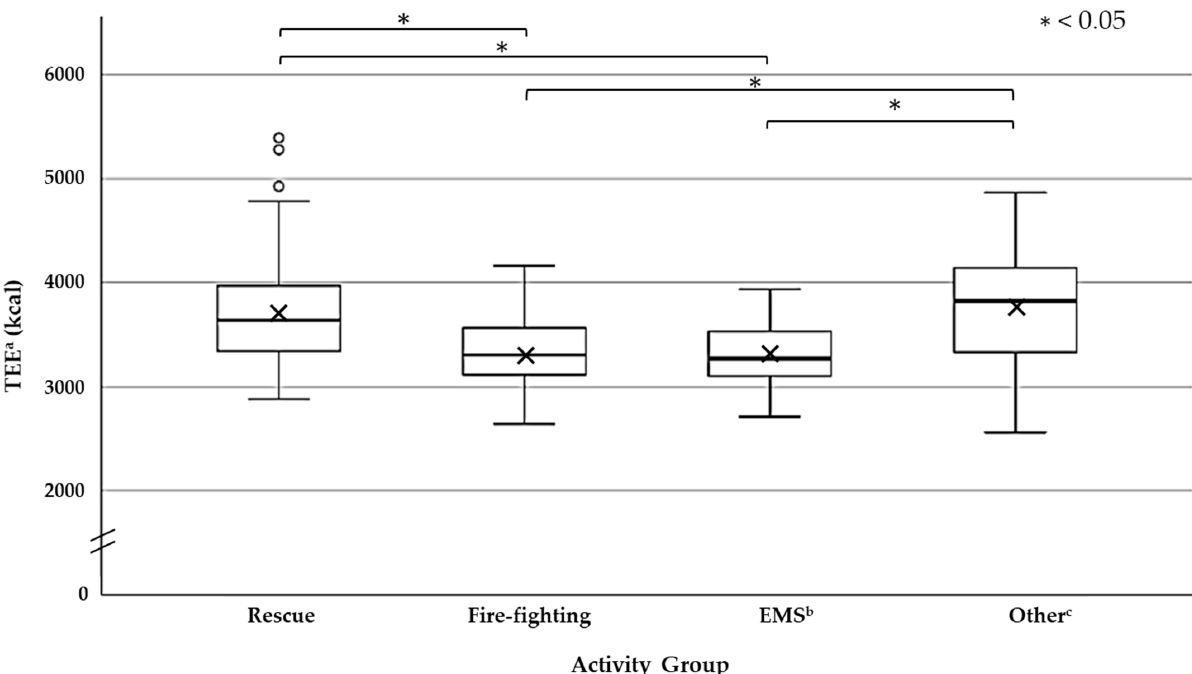
Figure 2. Total energy expenditure (TEE) of each disaster response Activity Group (24 h from arrival at the disaster site to the end of the disaster response activity during the two days of activity training). The TEE of the Rescue team and the other team * indicates significant (One-way analysis of variance and Tukey’s HSD method: p < 0.05) higher than the TEE of the Fire-Fighting team and the EMS team. × shows the average of each activity group in the box plot. ∘ shows the outlier. a , TEE=Total energy expenditure, b , EMS=Emergency medical service, and c , Other=Command and back up unit.